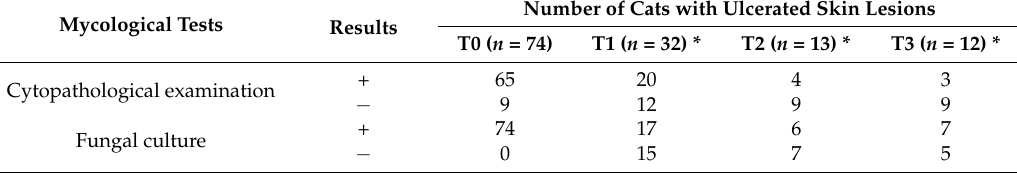
Table 1. Results of fungal culture and qualitative cytopathological examination from ulcerated skin lesions of cats with sporotrichosis during treatment with itraconazole, Lapclin-Dermzoo/INI/Fiocruz (2013–2015).